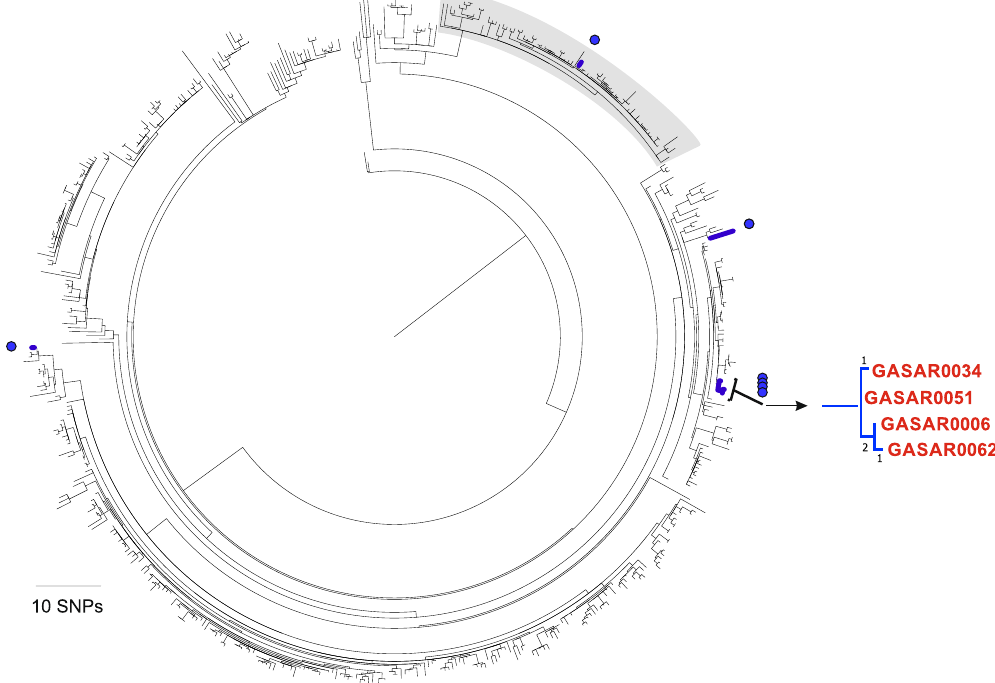
Figure 4. Diverse and closely related isolates within emm 3. A maximum-likelihood phylogenetic tree was constructed using core genome SNPs (excluding prophages) identified in sequenced emm 3 strains from our collection (n = 7), emm 3 strains isolated 1992–2007 from Canada (n = 70) 26 , and emm 3 strains isolated 2001–2013 from UK and Ireland (n = 442) 8 , compared to the reference emm 3 genome strain MGAS315. Isolates from our collection are highlighted in blue branches and blue circles around the outside of the tree. One of our isolates resided within the previously identified Lineage C (lineage highlighted grey) associated with an increase in invasive disease in the UK 8 . This strain, like the majority of others within this lineage, carries the superantigen speC and the DNase spd1 but has lost the superantigen ssa . An expanded region of the main tree is indicated on the right hand side and highlights four 2009 isolates that are separated from each other by only 1–4 SNPs. Branch labels represent number of